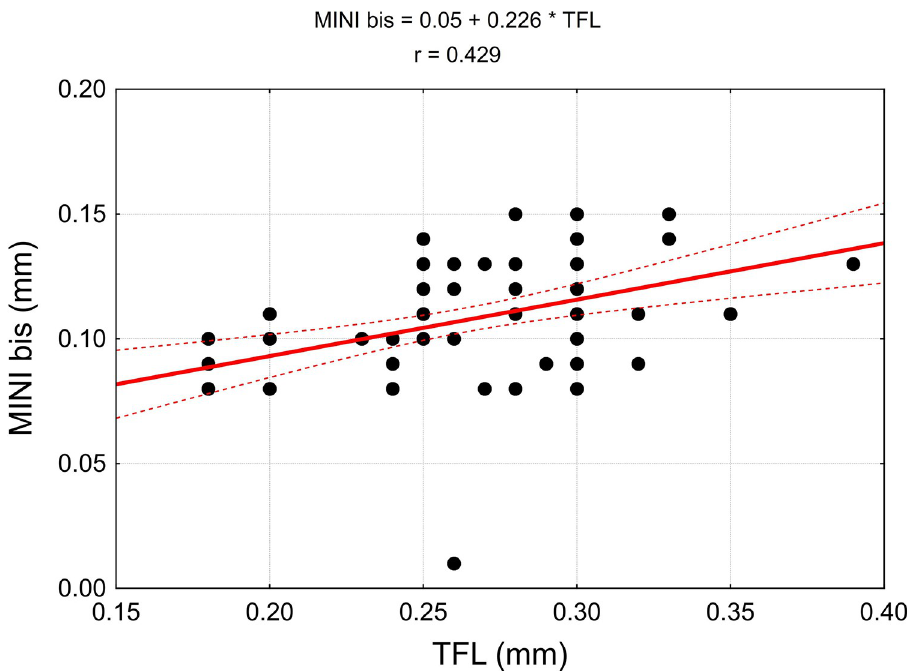
Fig 18. Correlation diagrams for the width of the nerve branch to the tensor fasciae latae muscle (TFL) with the width of the piriformis muscle (MP), the width of the main branch to the gluteus medius muscle (MED), the average width of the branches emerging from the main trunk of the nerve to the gluteus minimus muscle (MINI) and the average total width of the branches departing from the main trunk of the examined nerve (MINI bis).